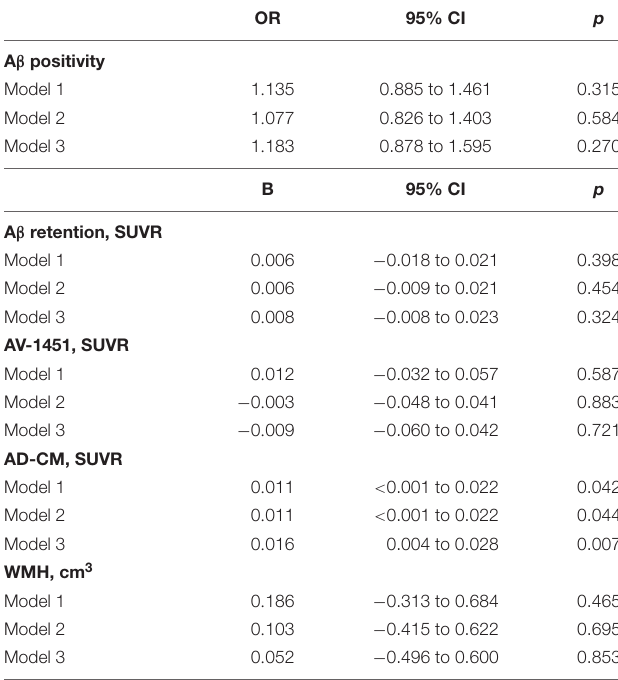
TABLE 4 | Results of multiple logistic and linear regression analyses for assessing the relationship between serum UA and A β , AV-1451, AD-CM, or WMH volume in cognitive normal older adults.